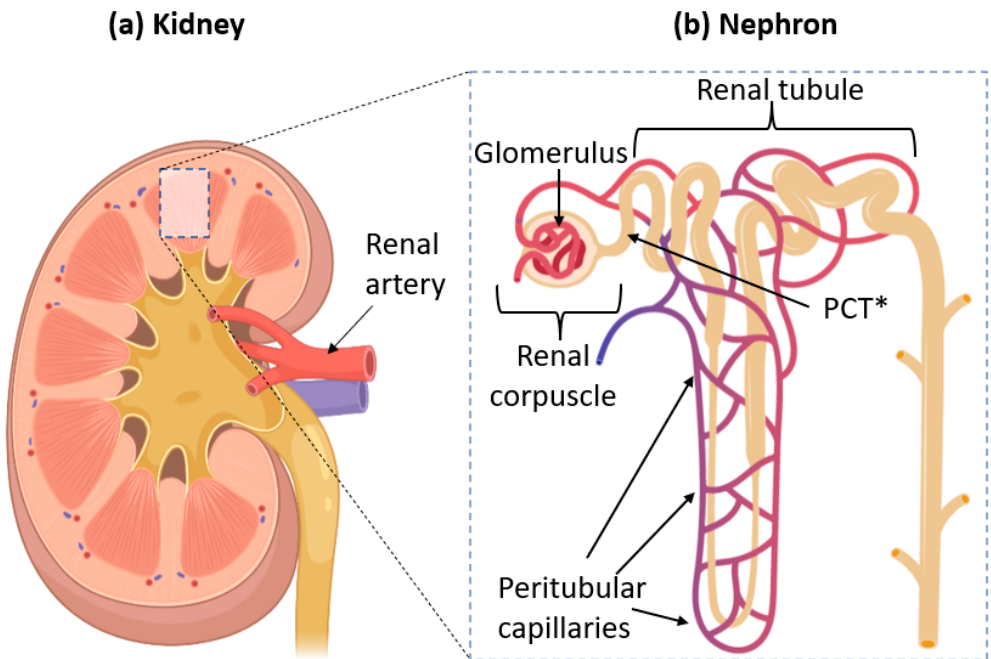
Figure 1. ( a ) Anatomy of a kidney, showing where one can find nephrons. Blood is supplied to the kidneys through the renal artery. ( b ) Structure of a single nephron. Filtration of blood occurs in the renal corpuscle. The renal artery splits into smaller vessels called arterioles, which form bundles of vessels inside the corpuscle called glomeruli. * PCT = Proximal Convoluted Tubule, the section of the renal tubule which is directly connected to the renal corpuscle. The whole of the tubules is surrounded by peritubular capillaries, which carry filtered blood from the glomeruli.